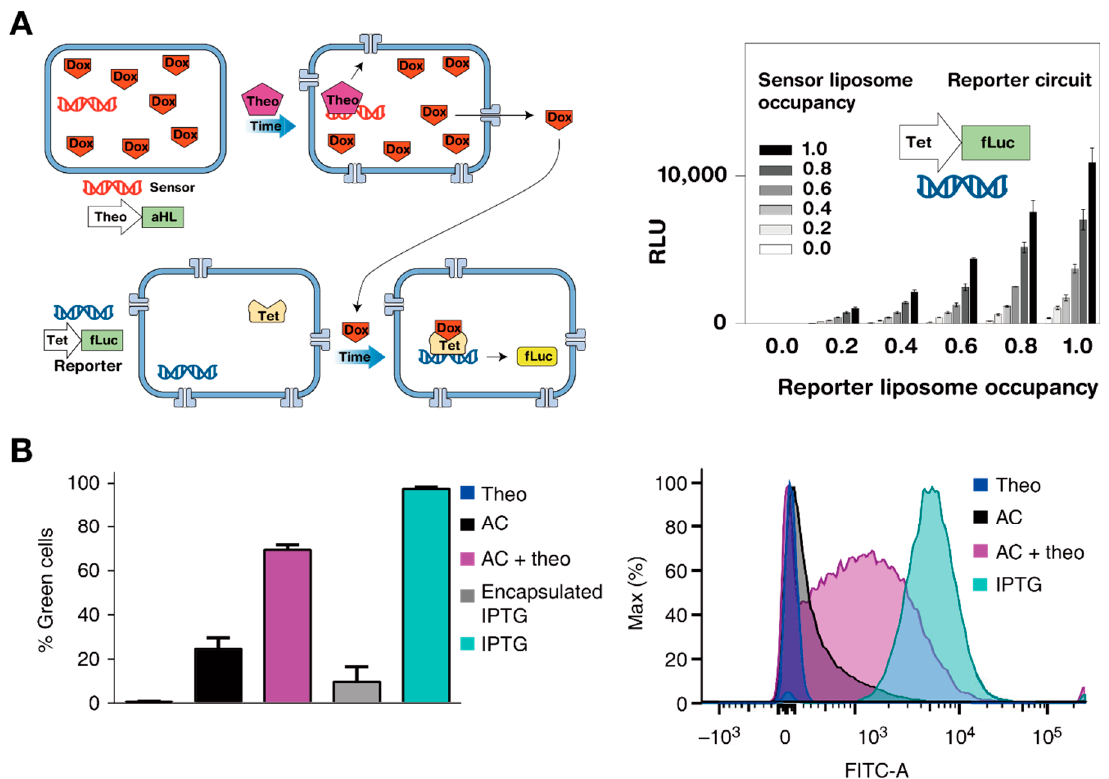
Figure 8. Interconnecting artificial and natural cells. ( A ) (left) Schematic design of synthetic sensor and reporter liposome pair, which contain bacterial and mammalian TXTL machinery, respectively. α -hemolysin (aHL) produced by theophylline treatment in the sensor liposome releases internal doxycycline to the environment, which in turn triggers expression of fLuc in the reporter liposome. (right) Expression of fLuc in different ratios of sensor and reporter liposomes. Occupancy refers to the ratio of droplets that contain TXTL machinery for both sensor and reporter droplets. Reproduced with permission from [105]. ( B ) (left) Flow cytometry data for E. coli containing a plasmid for GFP in the presence of the following components: theophylline (Theo), artificial cells (AC), artificial cells with theophylline (AC + Theo), isopropyl β -D-1-thiogalactopyranoside (IPTG) encapsulated in vesicles (Encapsulated IPTG), and IPTG in the bulk solution (IPTG). (right) Histogram of flow cytometry data shown in the left panel. Fluorescent signal is only increased in the presence of artificial cells and theophylline. Reproduced with permission from [115].